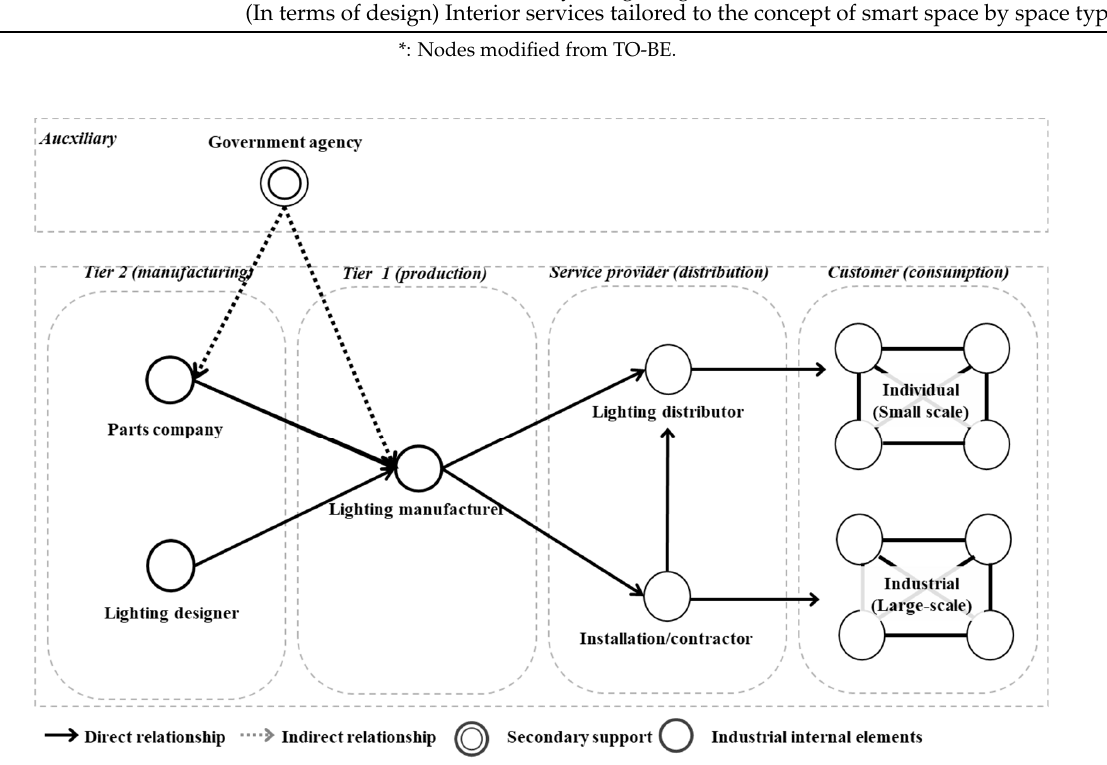
Figure 4. HCL AS-IS Ecosystem.